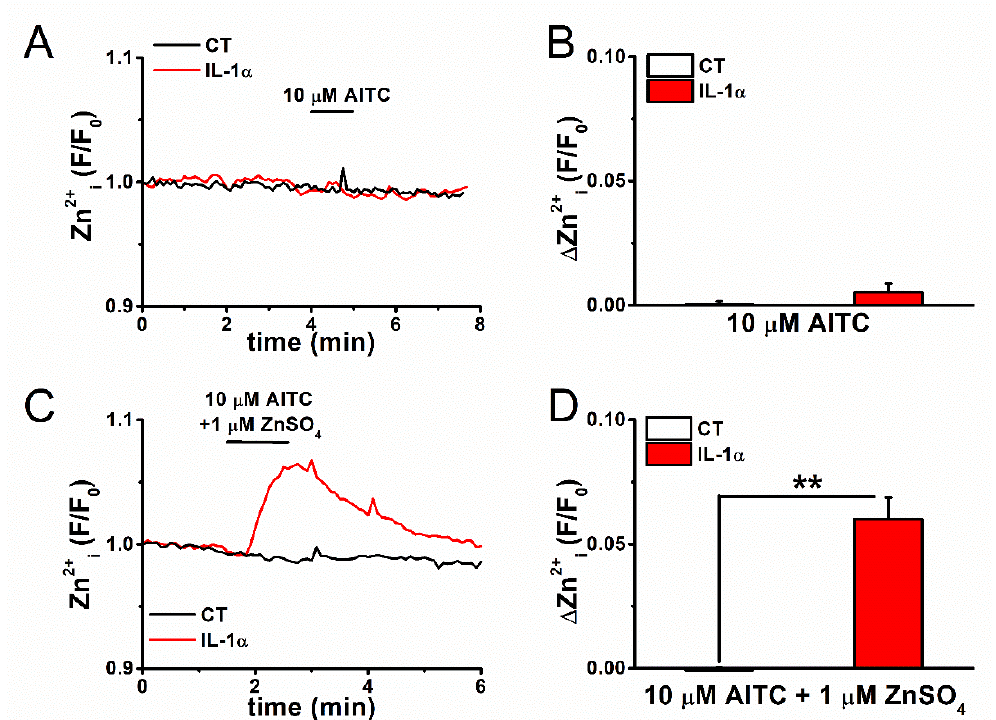
Figure 5. A change in [Zn 2+ ] i by activation of TRPA1 in FLSs. FLSs pretreated with and without 100 U IL- 1α for 24 h were exposed to AIT C at 10 μM, followed by monitoring of ( A ) [Zn 2+ ] i assayed by FluoZin-3 and ( B ) change in [Zn 2+ ] i (mean ± SEM; n = 16 and n = 28 for CT and IL- 1α, respectively, and three independent experiments each). ( C , D ) These experiments were repeated in FLSs the presence of 1 μM ZnSO 4 in the SBS to increase the driving force of Zn 2+ (mean ± SEM; n = 38 and n = 26 for CT and 100 U IL- 1α, respectively, and two independent experiments each; ** p < 0.01).